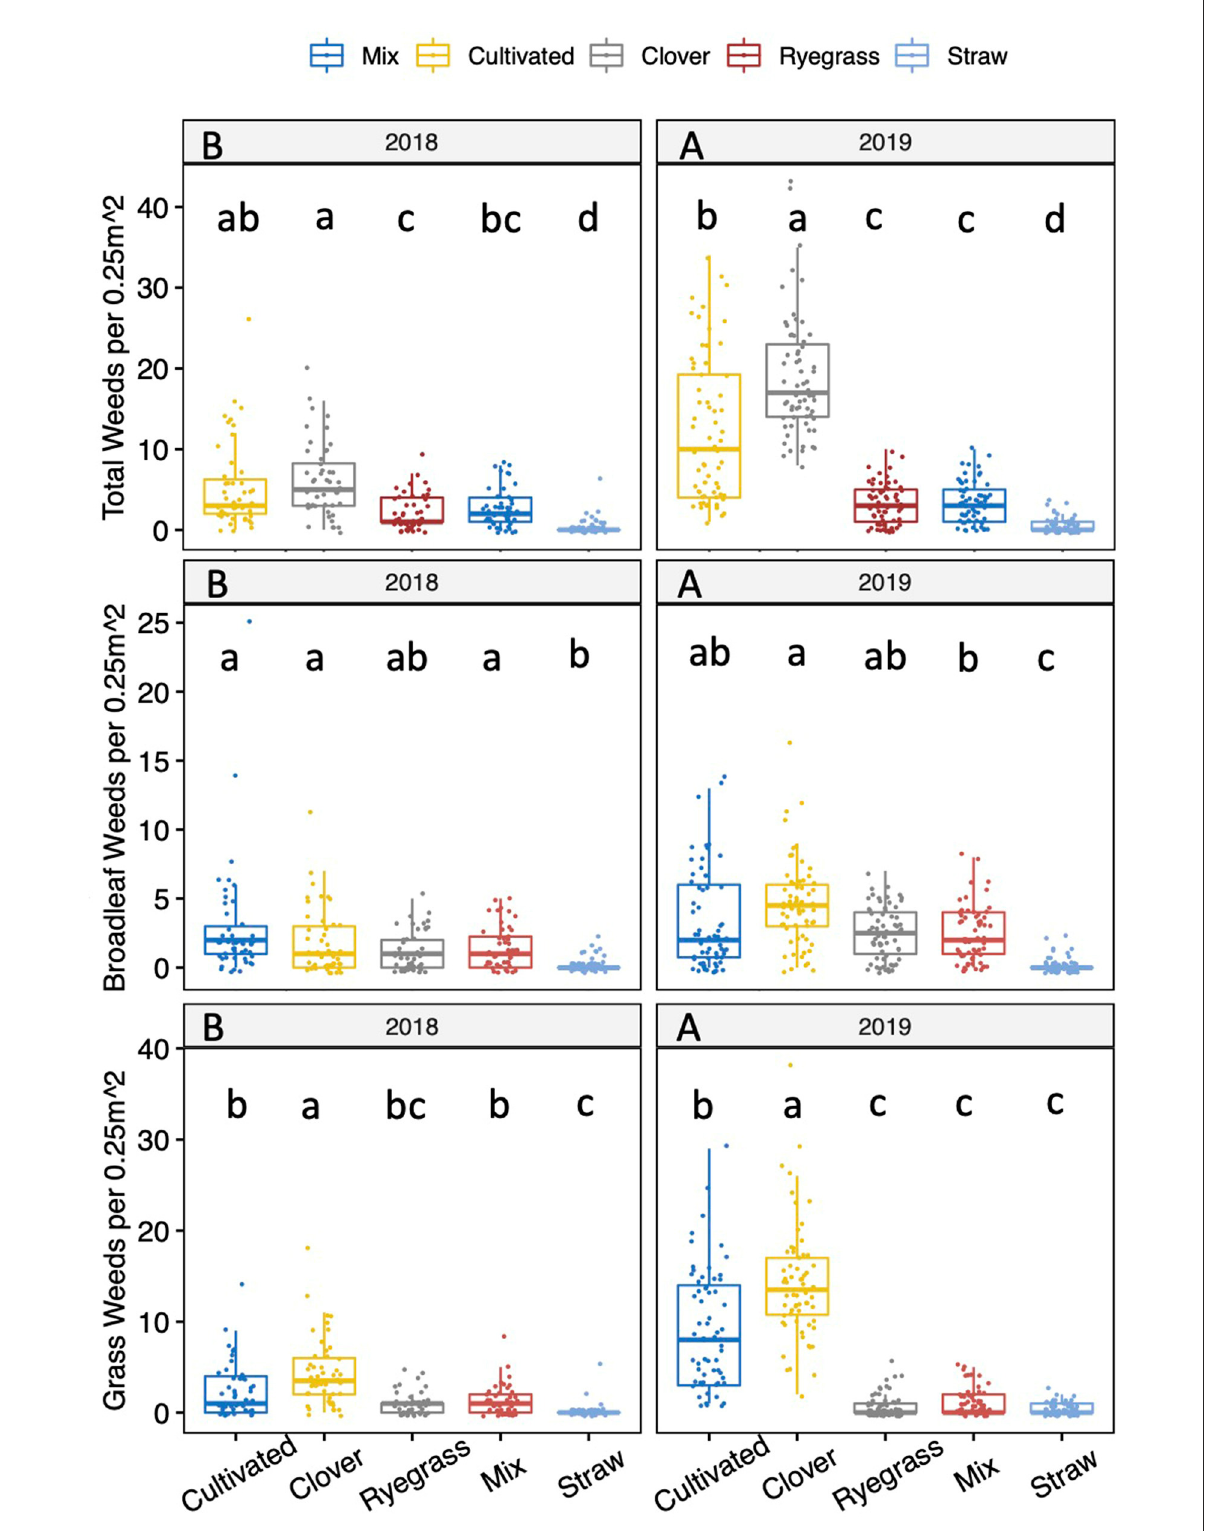
FIGURE6 Total (top) , broadleaf (center) , and grass (bottom) weed counts per 0.25 m 2 across dates and subsamples, 2018 and 2019. Lowercase letters indicate significance groupings within a given year and weed response variable, while uppercase letters indicate significance groupings for years across aisle mulch treatments. Groups that share the same letter are not significantly different at p <